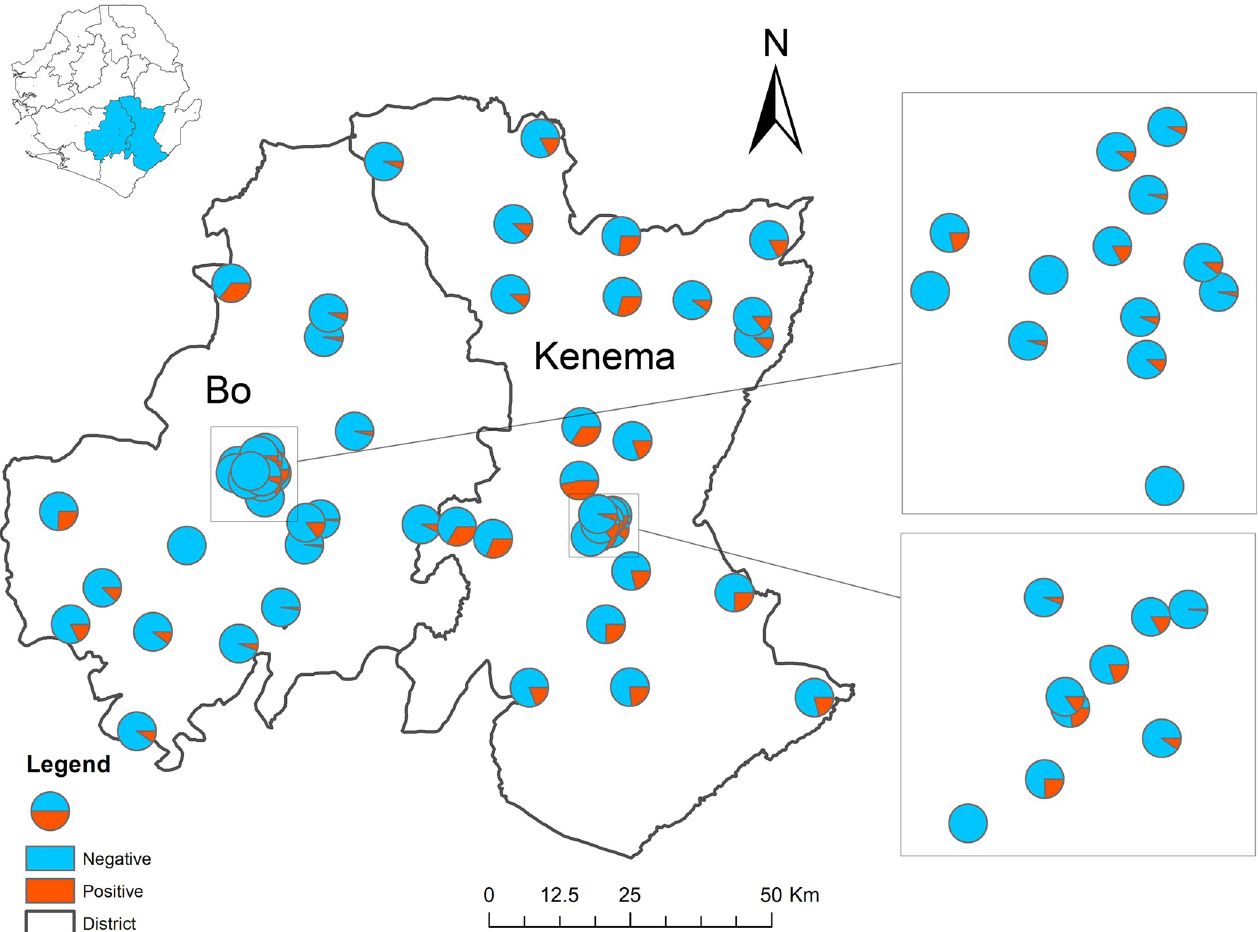
Fig 1. Map of survey clusters and the distribution of diagnostic results for soil transmitted helminthiasis. The base layer for this map was obtained from the GADM database (www.gadm.org), version 2.8: https://www.gadm.org/download_country_v2.html.